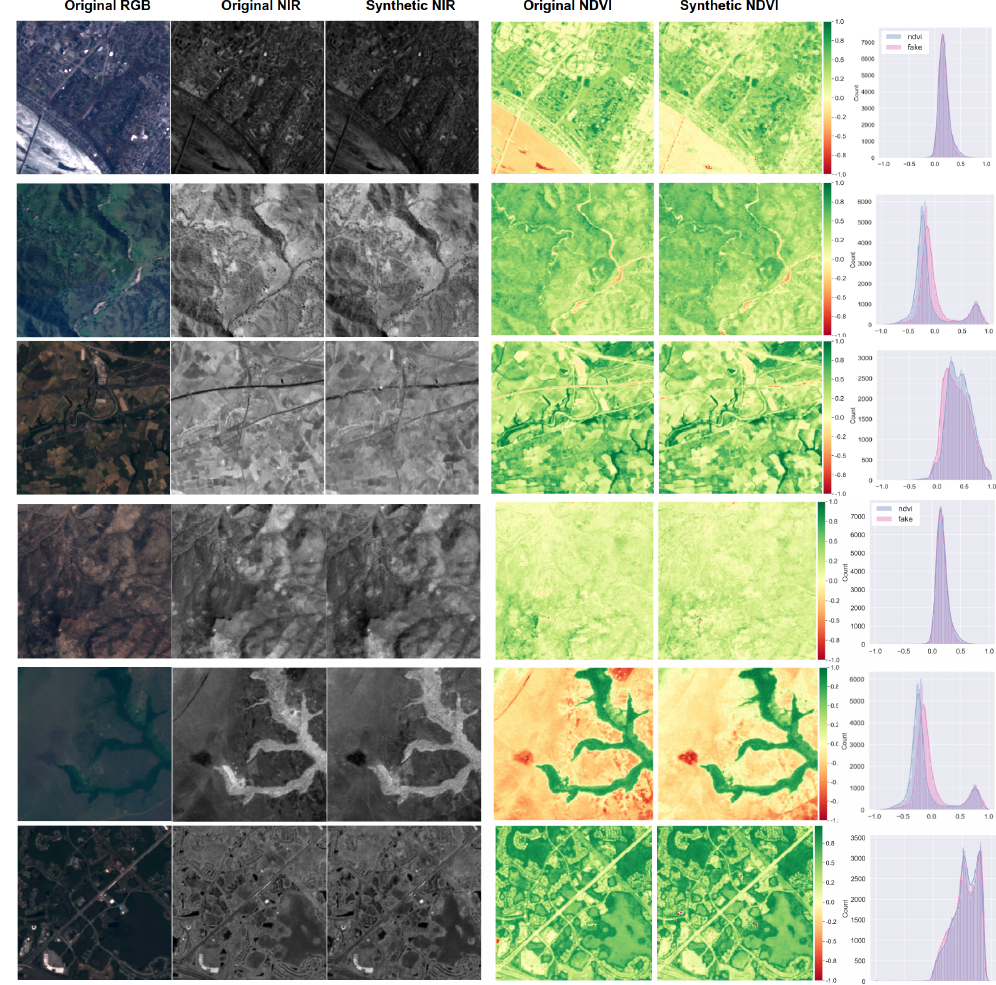
Figure 10. Six samples of SEN12MS dataset (1st and 2nd columns) and their corresponding synthetic NIR image (3rd) and NDVI images generated from original and synthetic NIR images (4th and 5th). The right most column shows pixel distribution for each NDVI images (red: synthetic, blue: